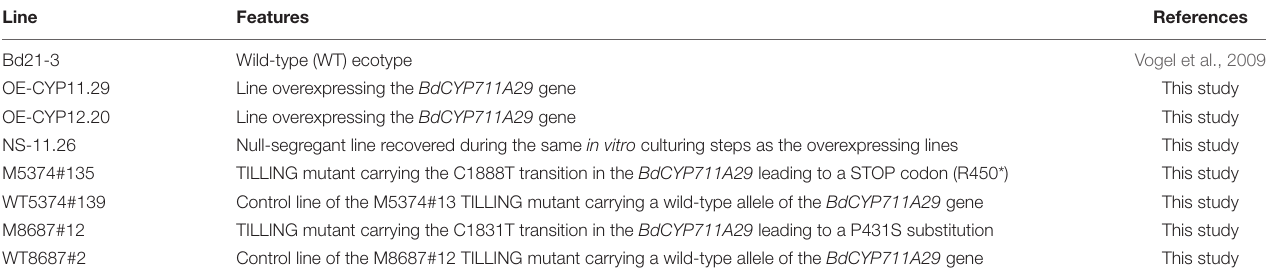
TABLE 1 | List and characteristics of the B. distachyon lines used in this